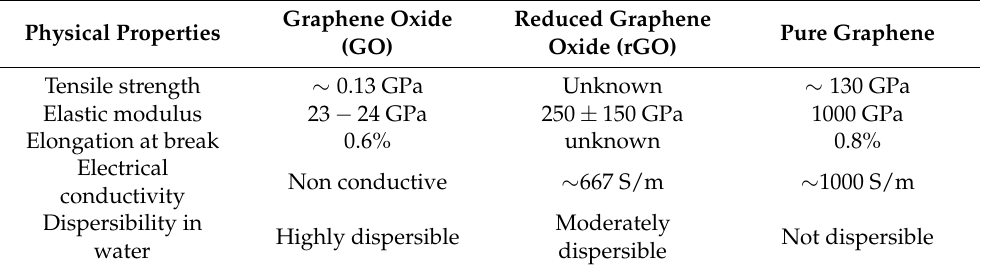
Table 1. Physical properties of graphene [15].